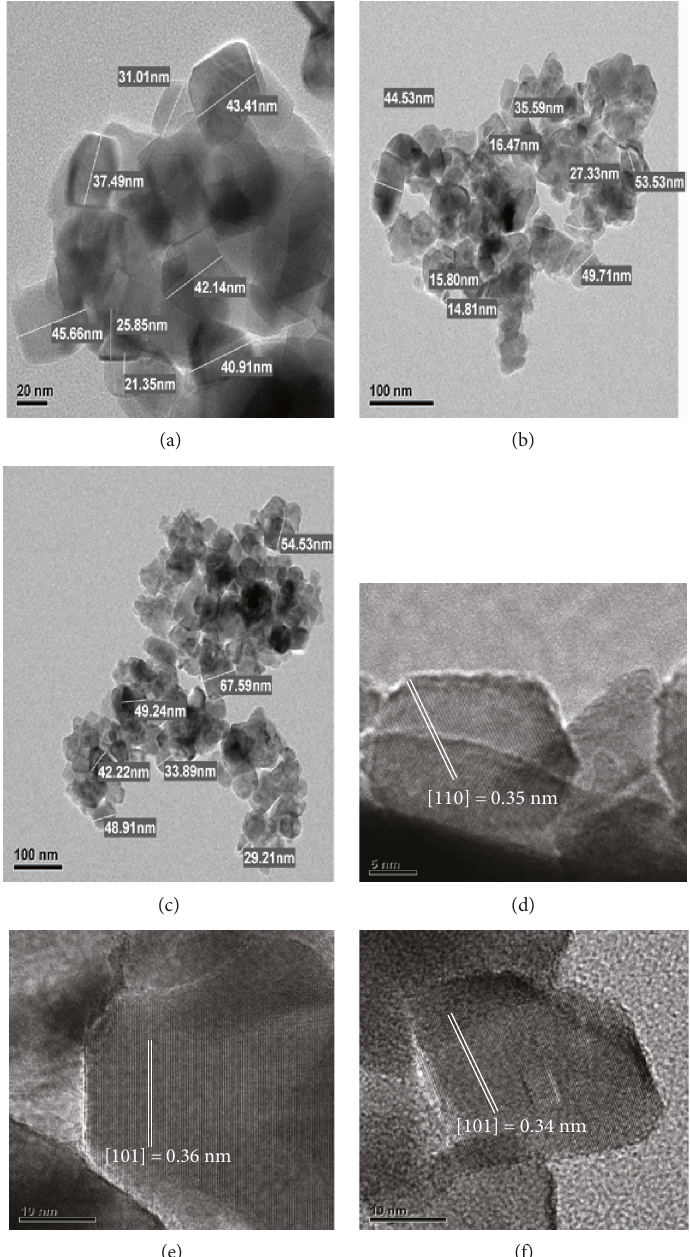
Figure 2: TEM images of (a) T rutile in T and (e and f) [101] crystallographic plane of anatase in (NS) control